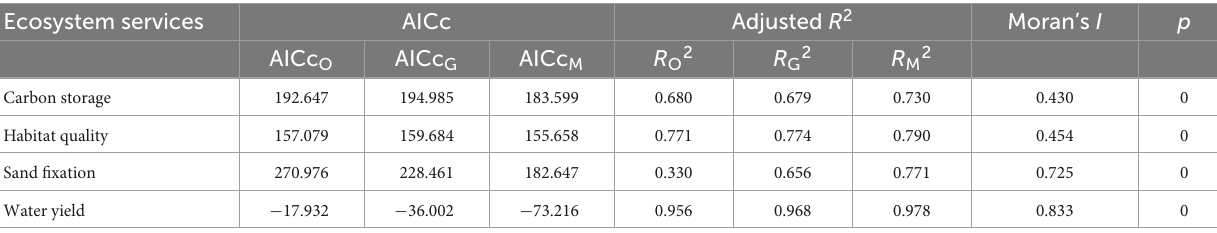
TABLE 3 Comparison of OLS, GWR, and MGWR model parameters. Ecosystem services